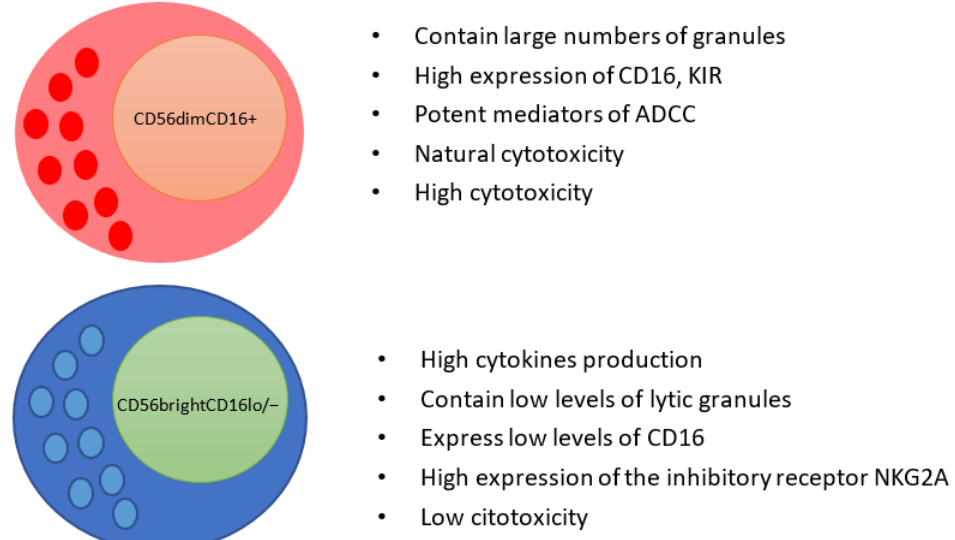
Figure 2. CD56bright and CD56dim NK cell subpopulations express differential receptor profiles and have different innate immune functions. CD56brightCD16low/ − NK cells secrete large amounts of cytokines but low expression levels of lytic granules and the Fc γ RIII (CD16). In addition, they have a high expression of the inhibitory receptor NKG2A. In contrast, CD56dimCD16+ NK cells contain large numbers of granules, express high levels of CD16, KIR, are potent mediators of ADCC, LAK activity, and natural cytotoxicity.